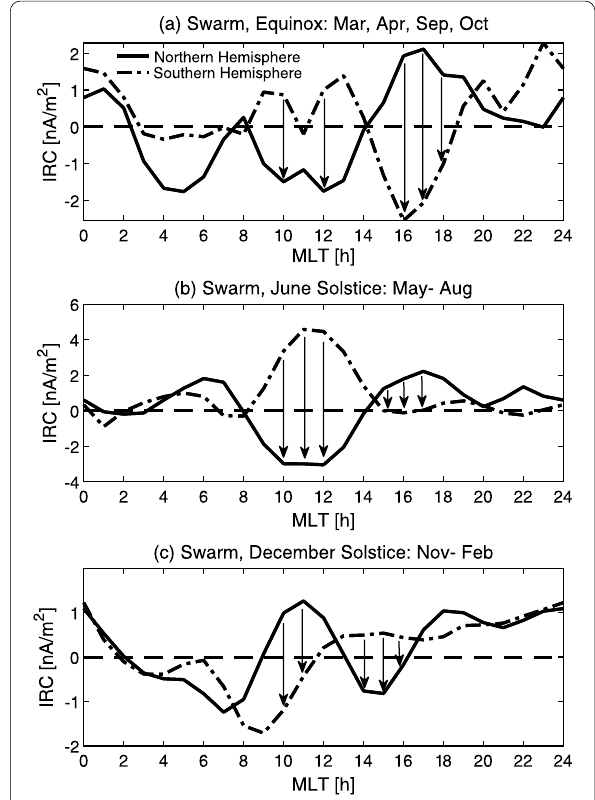
Fig. 1 Local time distributions of the ionospheric radial current (IRC) in the equinox (top), June solstice (JS, middle), and December solstice (DS, bottom). The solid and dashed lines illustrate IRC in the Northern (5°–15° MLat) and Southern Hemispheres ( 15° to 5° MLat), − − respectively. The arrows represent the direction of flow between the northern and southern hemispheres of IRC. The negative and positive values represent the radially inward and outward currents, respectively. The bin width is 1 h in local time. March, April, September, and October were selected for the combined equinox, November to February for DS, and May to August for